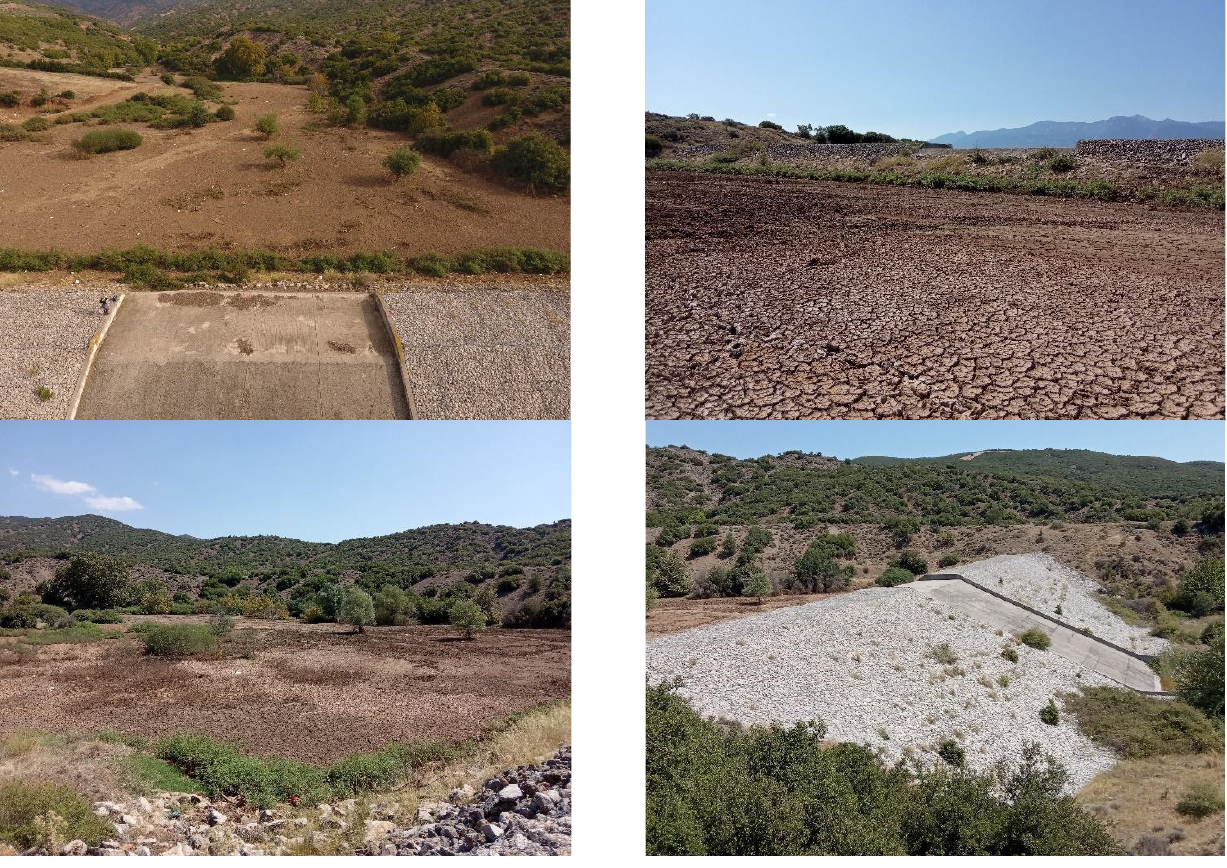
Figure 2. View of the Platana sediment retention dam features: perspective view of downstream slope (face) ( upper left panel ), upstream slope ( upper right panel ), reservoir ( lower left panel ), perspective view of the spillway and crest ( lower right panel ).